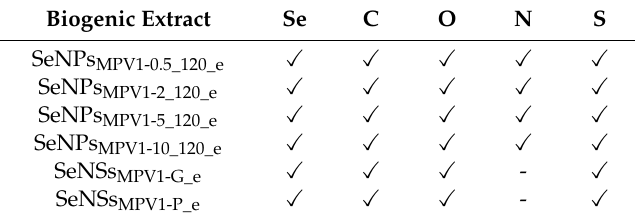
Table 4. Elemental composition of biogenic SeNS extracts obtained through EDX spectroscopy.